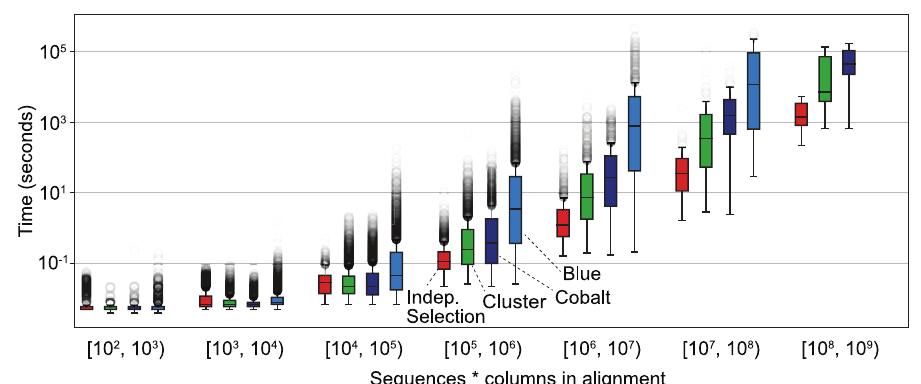
Fig 3. Runtime of algorithms. Each algorithm was run once on each Pfam seed and full alignment for at most 6 days. The runtimes are reported as a function of the product of the number of sequences and the number of columns in the alignment, as bar plots including outliers (translucent grey circles). The boxes extend from the first to third quartile, and the median is marked by a horizontal line. The results for families with at most 10,000 sequences were obtained on 2 cores and 8 GB of RAM, and the remaining were obtained on 3 cores and 12GB of RAM. The results do not include 34 families that Blue did not finish running within 6 days. Blue finished 939 of 944 families in the [10 6 , 10 7 ) range, 58 of 85 families in the [10 7 , 10 8 ) range, and 1 of 3 families in the [10 8 , 10 9 ) range (and we omitted a bar plot for Blue for [10 8 , 10 9